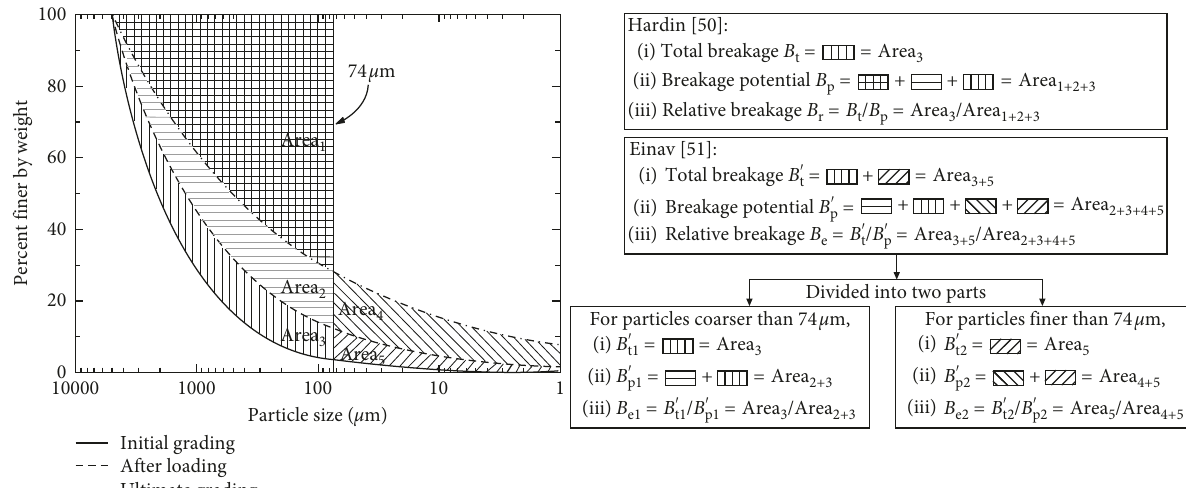
Figure 9: Definitions of the particle crushing indexes B